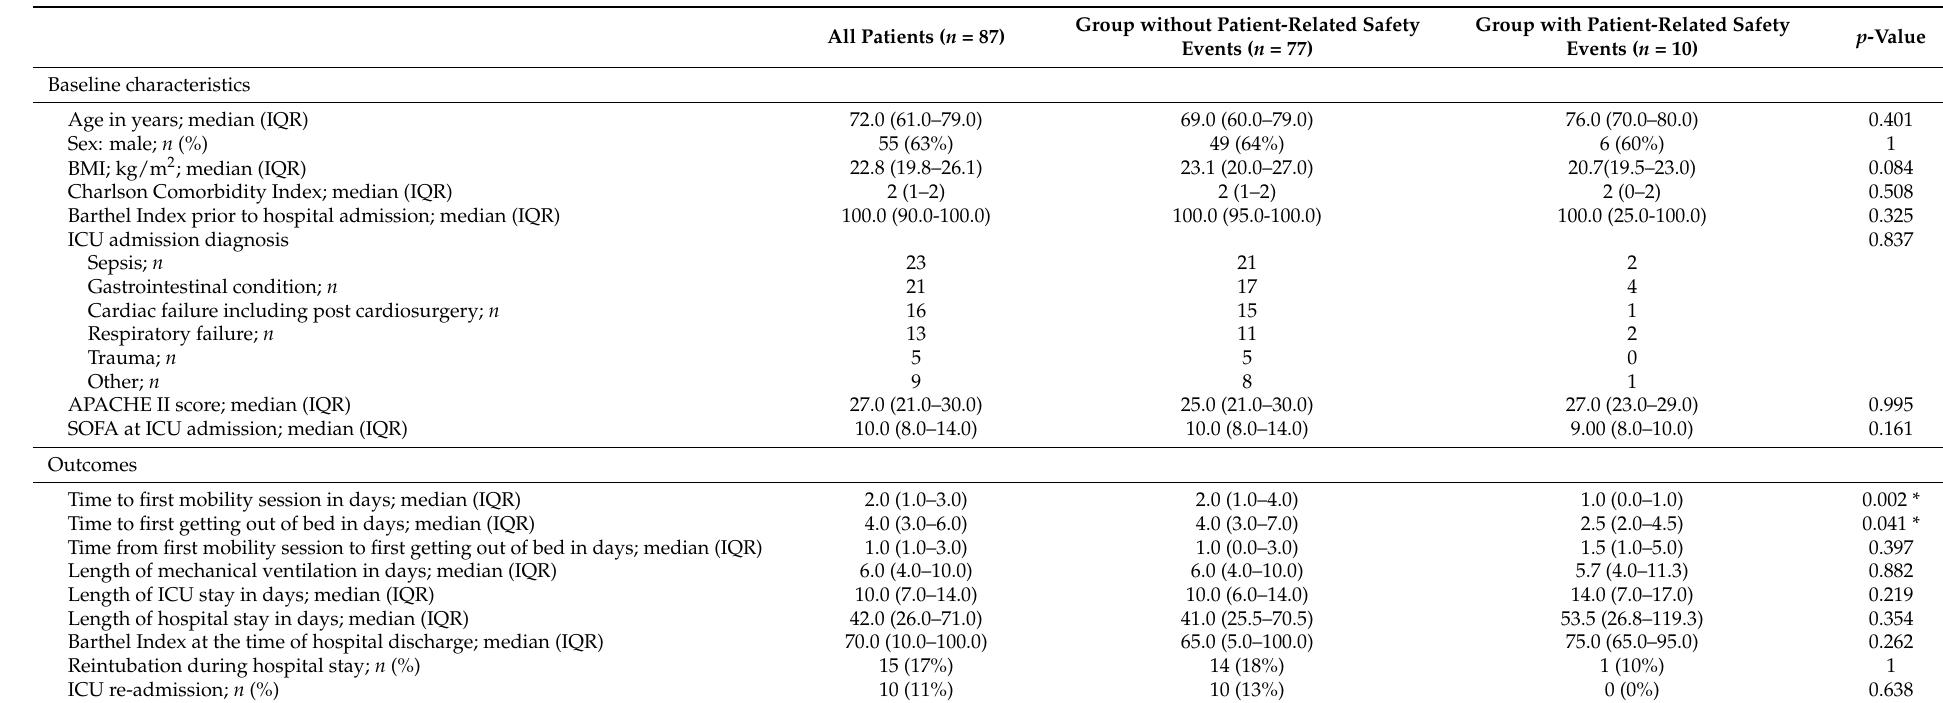
Table 1. Baseline characteristics and outcomes of patients undergoing mobilization